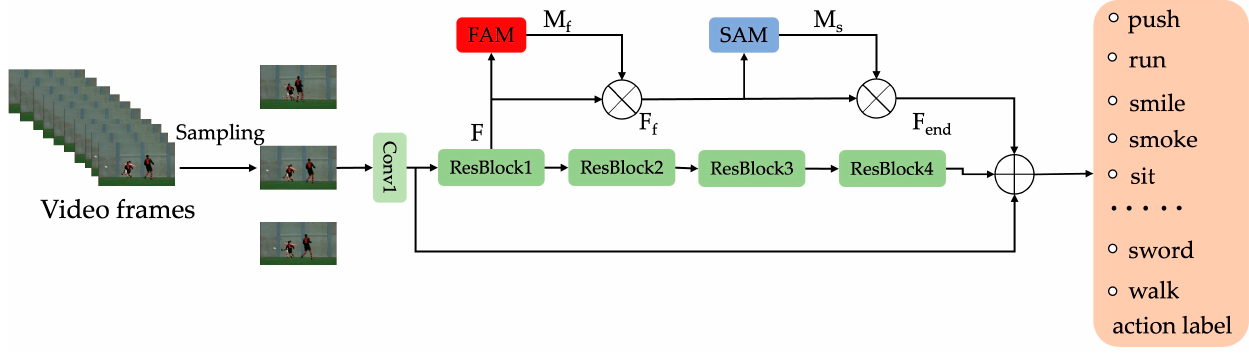
Figure 4. The overview of the FSAN.